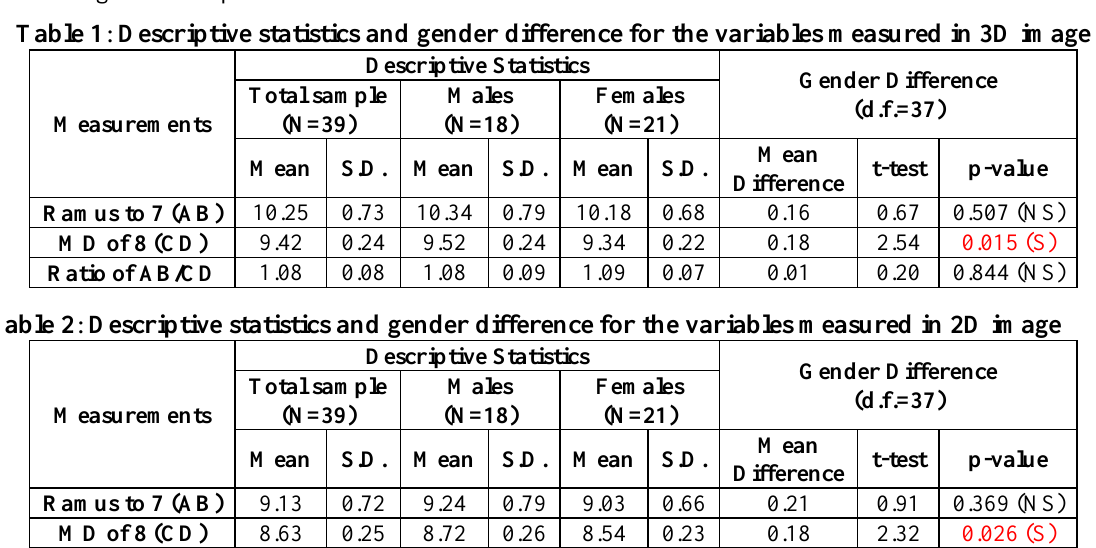
Table 1 : Descriptive statistics and gender difference for the variables measured in 3D image Measurements